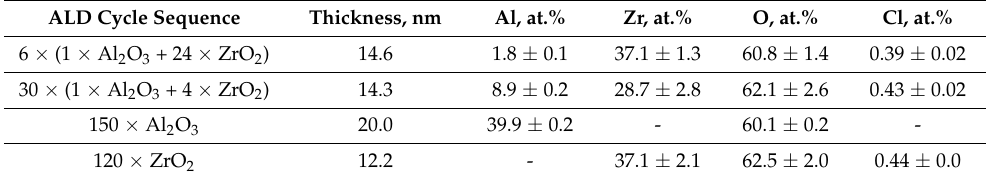
Table 1. ALD cycle sequence, thickness, and elemental composition measured by XRF for ZrO 2 :Al 2 O 3 films designed as periodical multilayers with uniform distribution of Al 2 O 3 layers throughout the thickness of the host ZrO 2 medium. The measurement uncertainty ranges for atomic percentages express the differences between measurement results obtained on different locations of samples on substrate holder, due to the lateral thickness and composition profile.